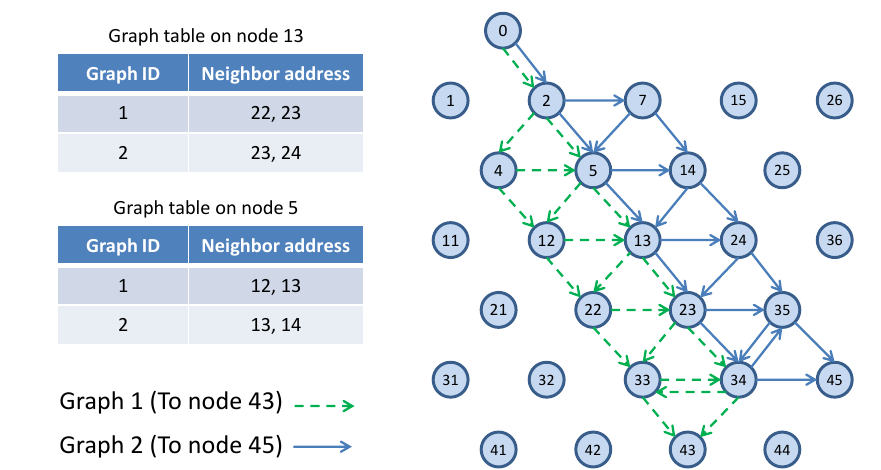
Figure 3. Graph routing